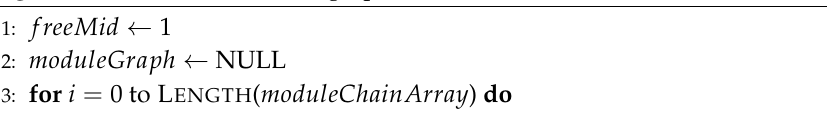
Algorithm 1 Generate module graph based on module